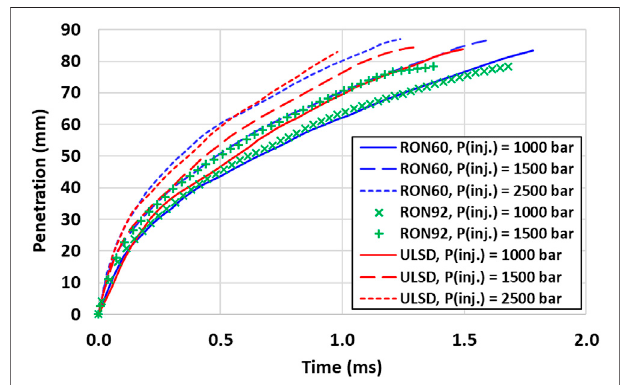
FIGURE 15 | Fuel effect on non-vaporizing penetration at a charge gas density of 23 kg/m. 3 .